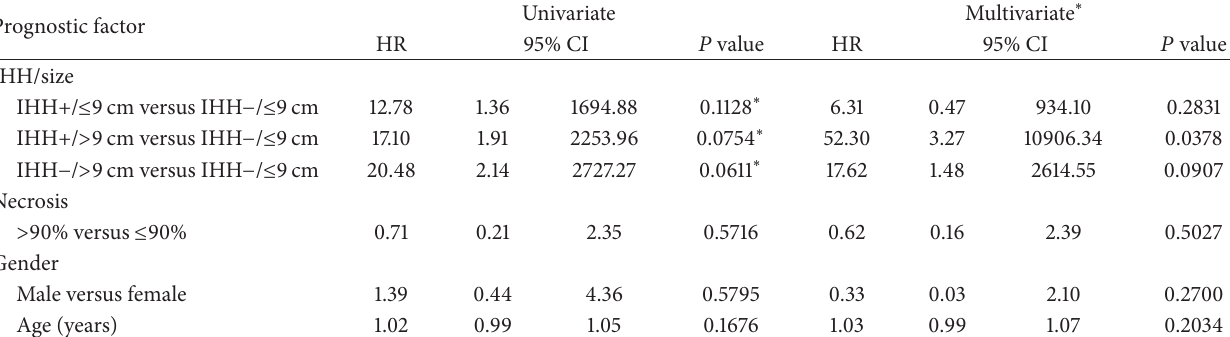
Table 3: Results of DFS analysis by Cox Proportional Hazards model in no metastasis at diagnosis group (𝑛 = 32) for IHH in combination with